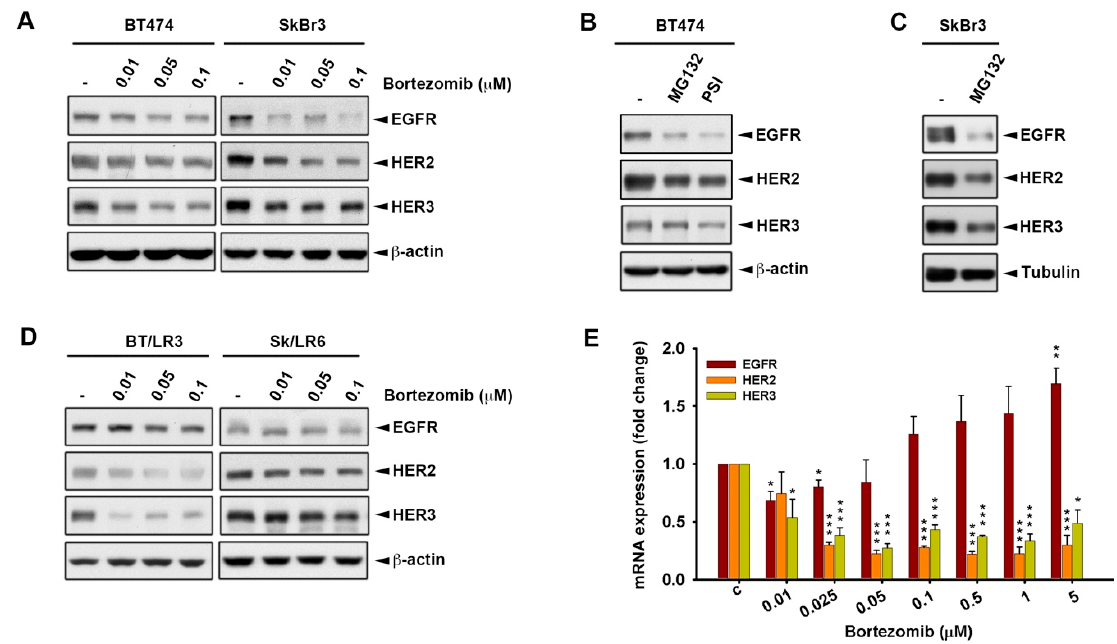
Figure 3. Proteasome inhibitors reduced the expressions of the ErbB family at both translational and transcriptional levels. Whole cell lysates of cells treated for three days with various concentrations of bortezomib ( A , D ), 10 µ M MG132, and 5 µ M PSI ( B , C ) were subjected to western blot analysis with indicated antibodies. The mRNA expression level of ErbB members in BT474 treated for three days with various bortezomib was analyzed by real-time quantitative reverse transcription polymerase chain reaction (RT-qPCR) ( E ). p values < 0.05, < 0.01, and < 0.001 are indicated as *, **, and ***, respectively.